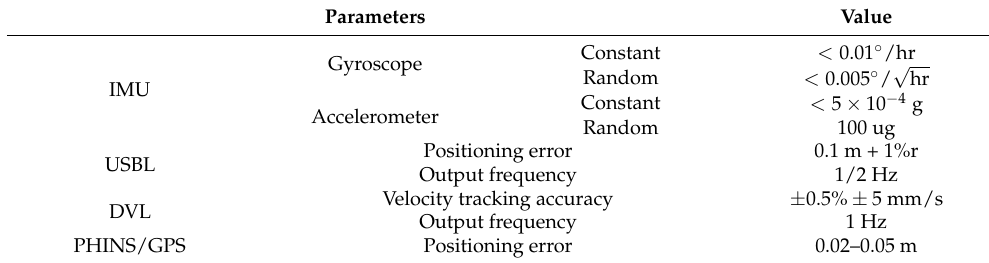
Table 2. Parameters of the sensors.